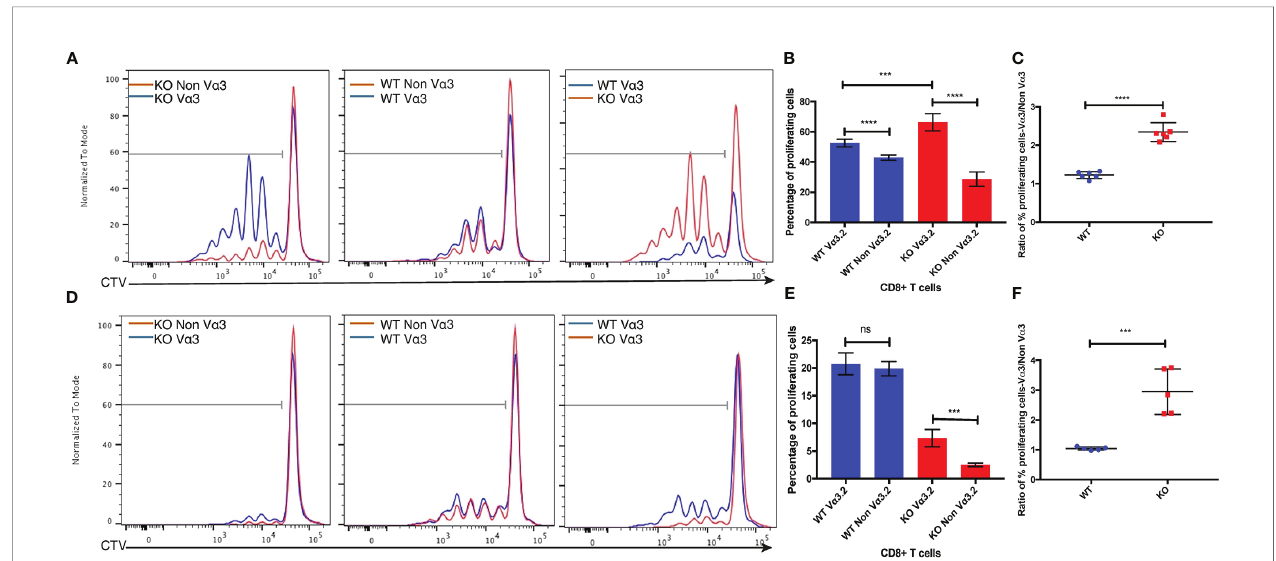
FIGURE 5 | Responses of V a 3.2 + CD8 + T cells to pro-in fl ammatory cytokine stimulation in vitro . (A) Proliferation of V a 3.2 + and non-V a 3.2 + naïve CD8 T cells from Themis – / – and Themis +/+ mice in response to IL-7 + IL-18 stimulation. (B) Histogram summary of the proliferative responses to IL-17 + IL-18 stimulation. (C) Ratio of % proliferating V a 3.2 + and non-V a 3.2 + CD8 + T cells upon IL-7 + IL-18 stimulation. (D) Proliferation of V a 3.2 + and non-V a 3.2 + naïve CD8 + T cells from Themis – / – and Themis +/+ mice in response to IL-7 + IL-12 stimulation. (E) Histogram summary of the proliferative responses to IL-7 + IL-12 stimulation. (F) Ratio of % proliferating V a 3.2 + and non-V a 3.2 + CD8+ T cells upon IL-7 + IL-12 stimulation. Data representative from three independent experiments with 4-5 biological replicates per genotype per experiment. ns not signi fi cant, ***p < 0.001, ****p < 0.0001 as determined by two-sided Student ’ s t-test. All error bars represent